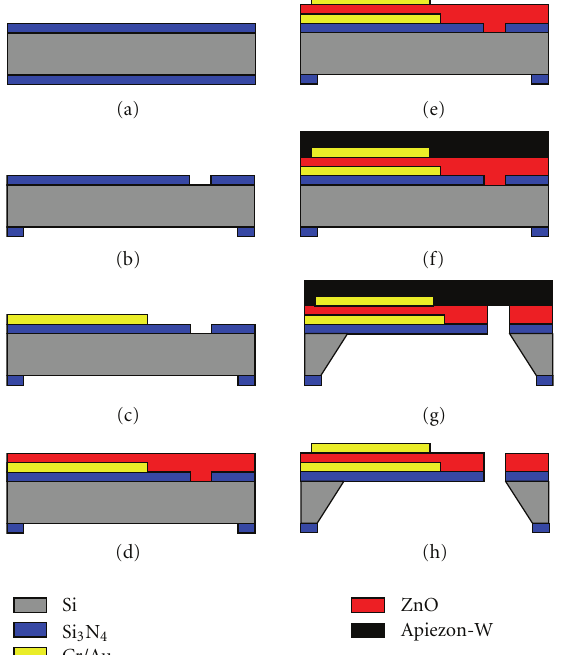
Figure 7: Fabrication processes of the sensor.